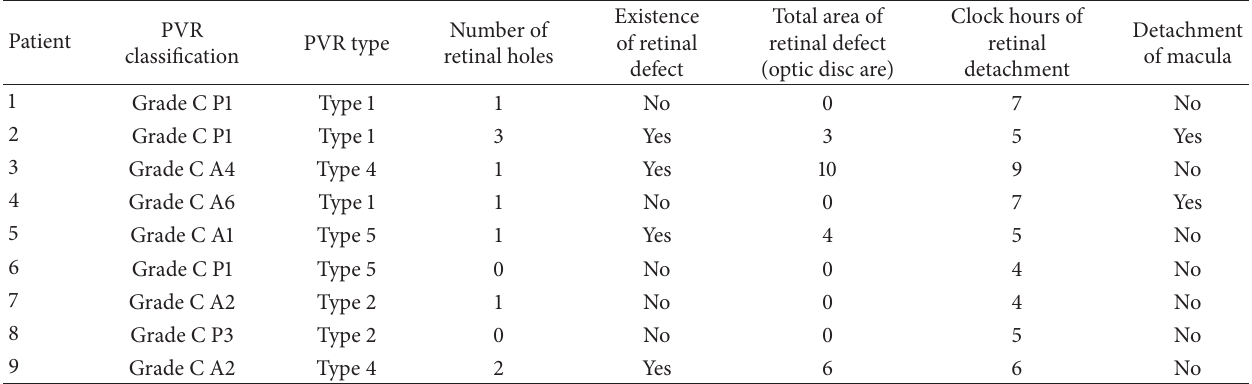
Table 2: Fundus characteristics at intraoperative examination.